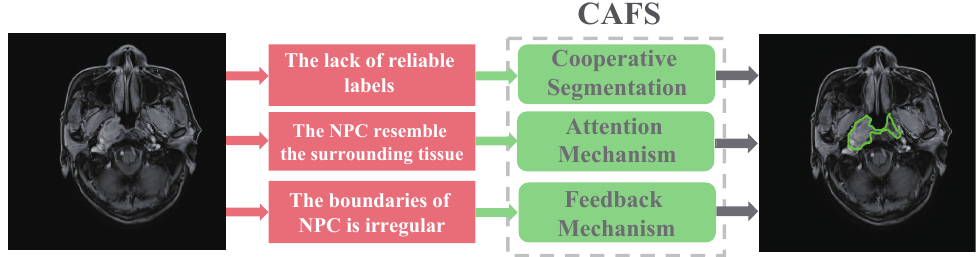
Figure 1. The task of CAFS is to automatically segment out the nasopharyngeal carcinoma boundaries by using only a small amount of labeled data. However, there are several challenges of segmenting nasopharyngeal carcinoma. First, reliable labeled data are difficult to obtain. Second, the nasopharyn- geal carcinoma resembles the surrounding tissue. Third, the boundaries of nasopharyngeal carcinoma are irregular. The CAFS utilizes the cooperative, attention mechanism, and the feedback mechanism to address these difficulties,